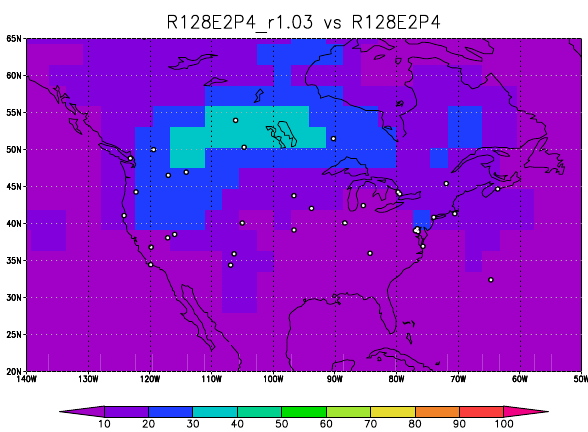
Fig. 8. Time-averaged differences [%] in AOT, for ρ =1.03 and 1.10 experiments. The black & white dots represent AERONET sites.